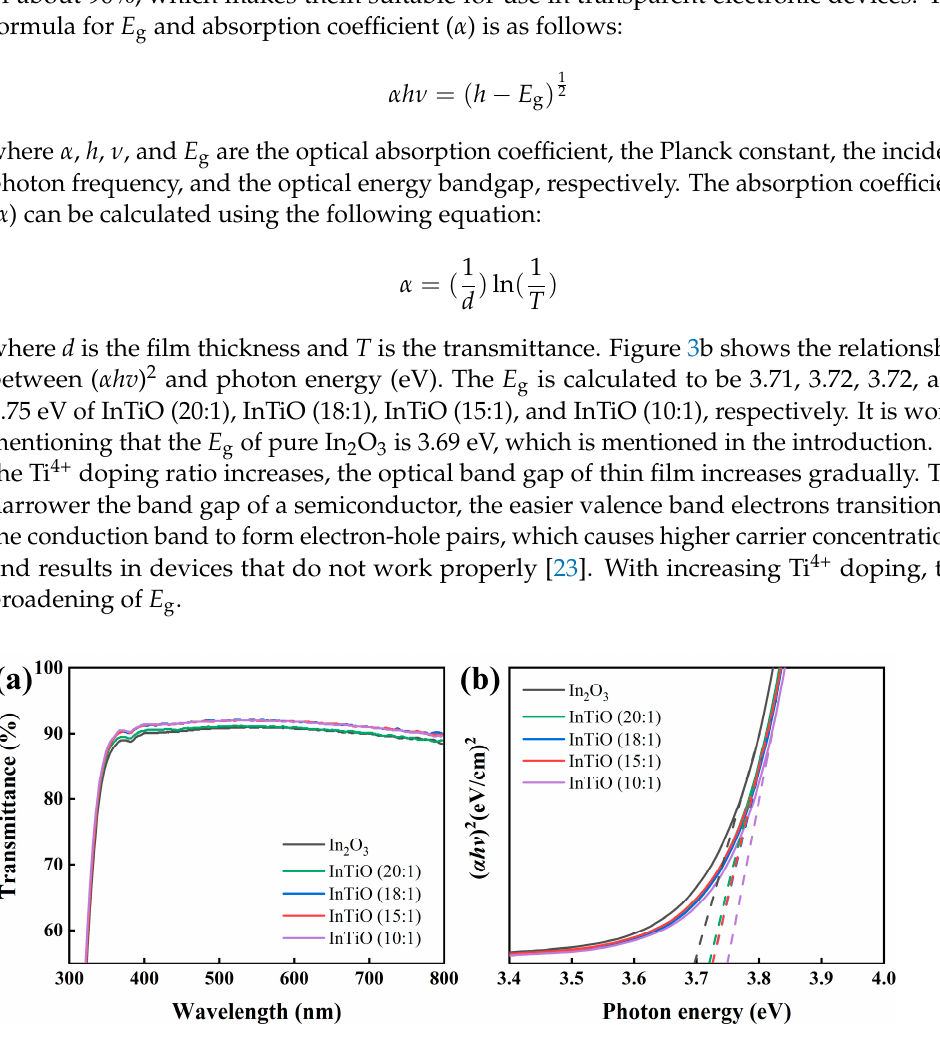
4 of 9 Figure 2. AFM images of ( a ) 20:1, ( b ) 18:1, ( c ) 15:1, ( d ) 10:1 InTiO thin films, and ( e ) XRD patterns.